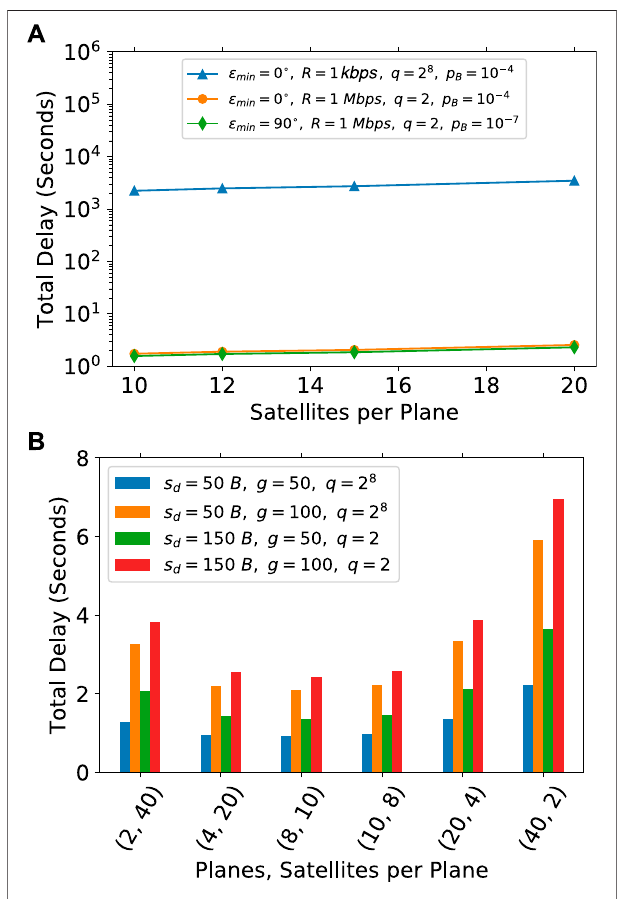
FIGURE 6 | Top panel shows the relationship between the total delay and number of satellites for four planes, where 100 segmentsare transmitted. The bottom panel shows the interplay between the number of planes and CubeSats per plane for a total number of 80